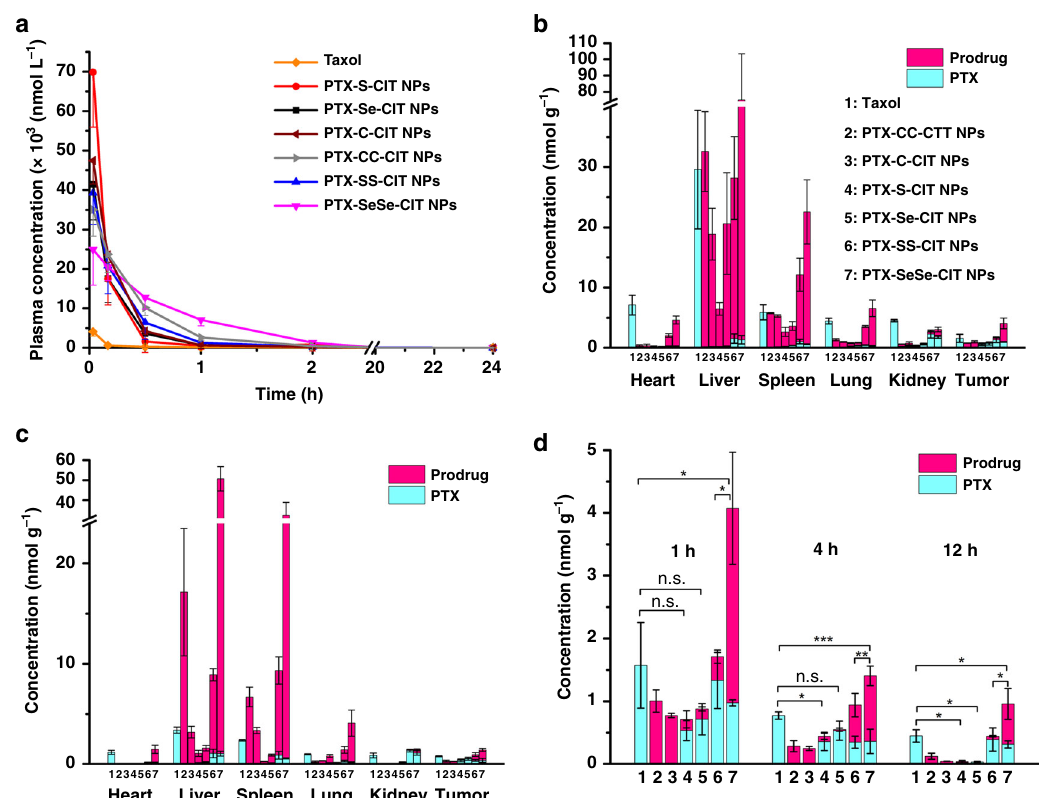
Fig. 4 Pharmacokinetic and in vivo biodistribution. ( a ) Molar concentration-time curves of the sum of released PTX and prodrugs. Data are presented as mean ± SD ( fi ve independent experiments). ( b , c ) In vivo biodistribution of Taxol and prodrug nanoassemblies at 1 h ( b ) and 4 h ( c ). ( d ) Tumor accumulation of Taxol and prodrug nanoassemblies. Data are presented as mean ± SD (three independent experiments). * P < 0.05, ** P < 0.01, *** P < 0.001 by two-tailed Student ’ s t